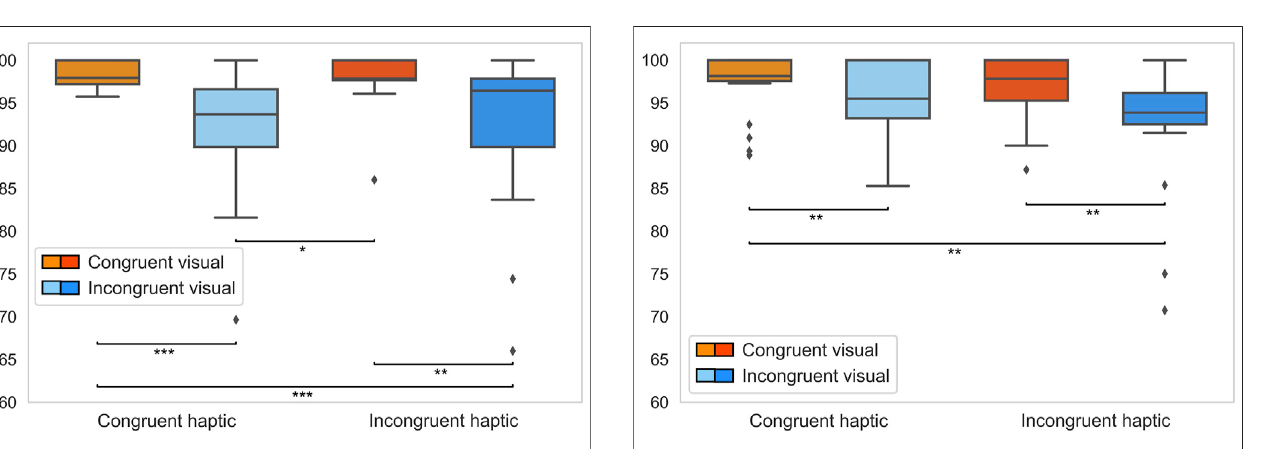
FIGURE 5 | Motor perception judgment accuracy across conditions (in percent).